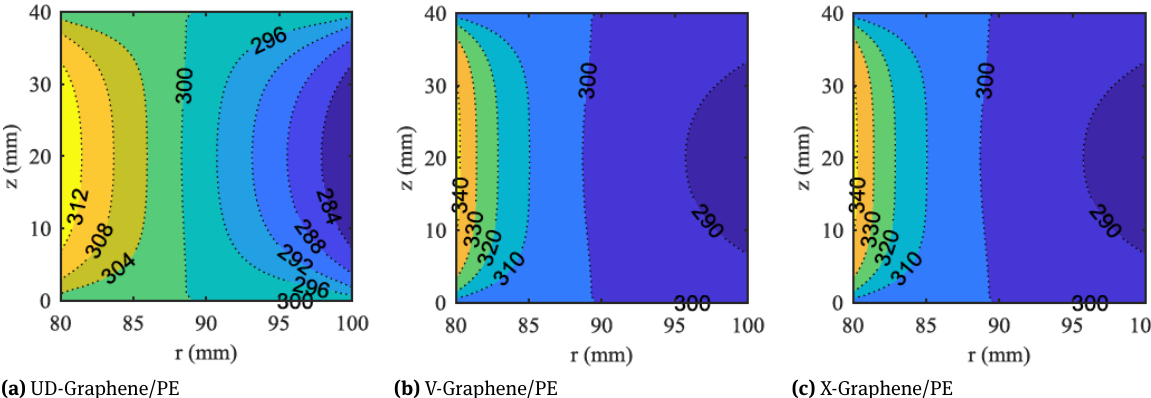
Figure 12: Two-dimensional temperature (K) profiles a) UD, b) V and c) X-graphene/PE cylinders subjected to Q i = 5 kW/ m 2 , h o = 150